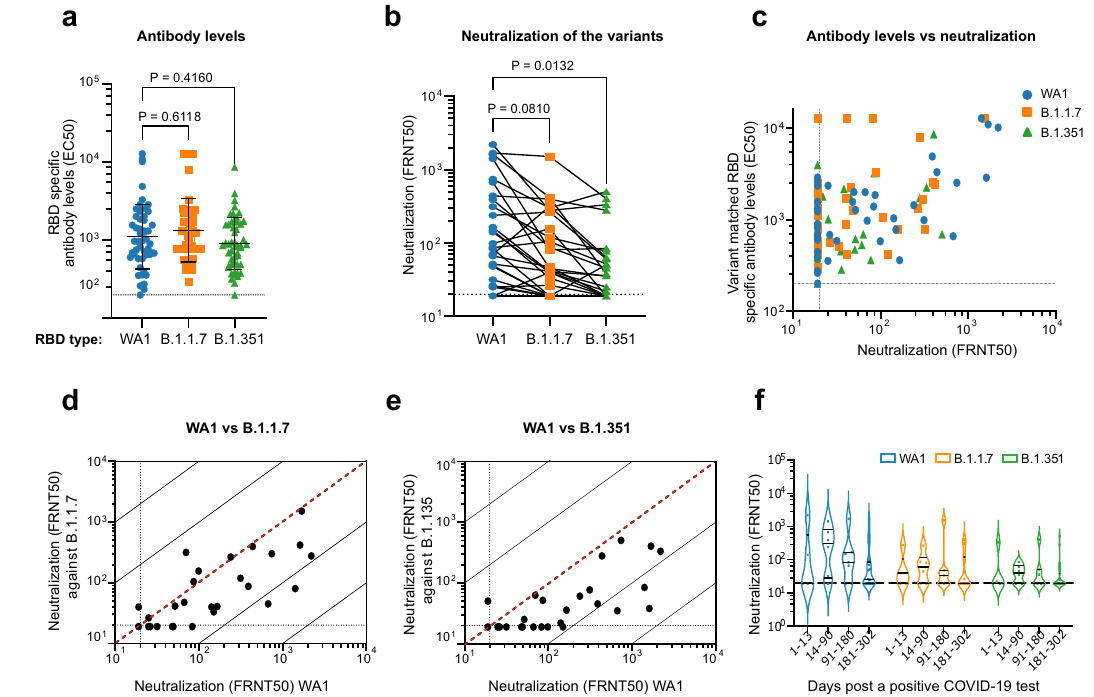
Fig. 2 Neutralization of SARS-CoV-2 variants by convalescent serum. a Quanti fi cation of serum antibody levels (EC50) that recognize RBD protein corresponding to the wild-type (WA1)(blue circles), B.1.1.7 (orange squares), and B.1.351 (green triangles) variants. n = 50 biologically independent samples. Data are presented as the mean ± SD of log transformed values. b Comparison of neutralization titers between WA1, B.1.1.7, and B.1.351 for convalescent sera. n = 44 biologically independent samples. c Relationship between convalescent antibody levels and neutralization (FRNT50) of the different viral variants. d , e Correlations between convalescent serum neutralization titer of the B.1.1.7 ( d ) and B.1.351 ( e ) variants with the WA1 virus. The dotted diagonal lines indicate identical neutralization, and the solid diagonal black lines indicate 10-fold differences in neutralization. f Violin plots indicating FRNT50 values for WA1 (blue), B.1.1.7 (orange), and B.1.351 (green), strati fi ed by the number of days between the date of con fi rmatory COVID-19 PCR test and the date of serum sample collection. Black bars indicate median FRNT50 for each group. For a , b , f P values are two-sided and include a Š idák multiple comparison correction. All experiments were performed in